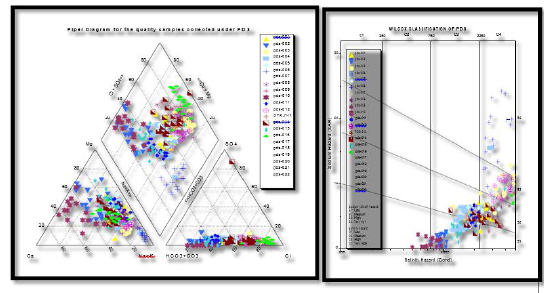
Figure 5 : Pepper Diagram for Water